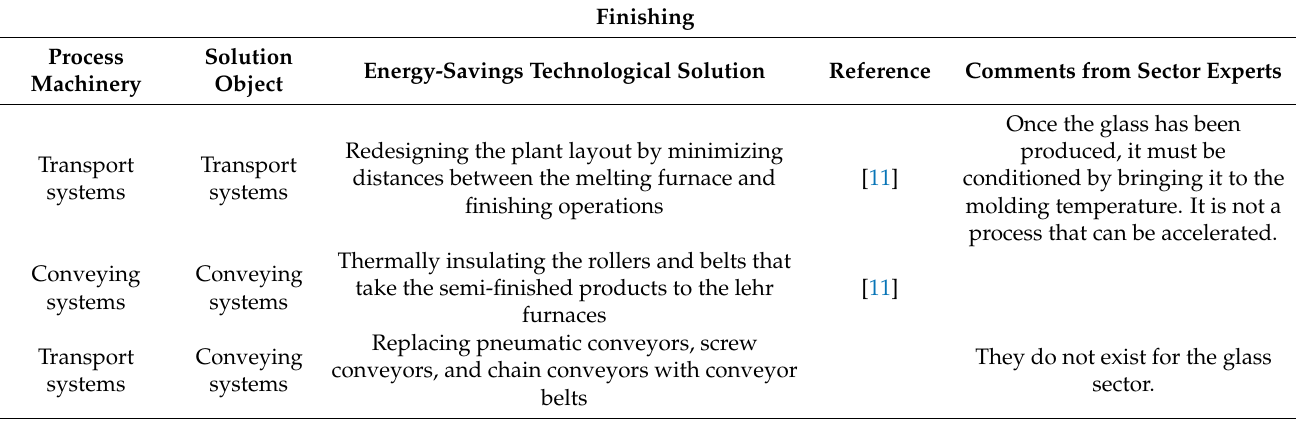
Table A4. Technology energy savings for